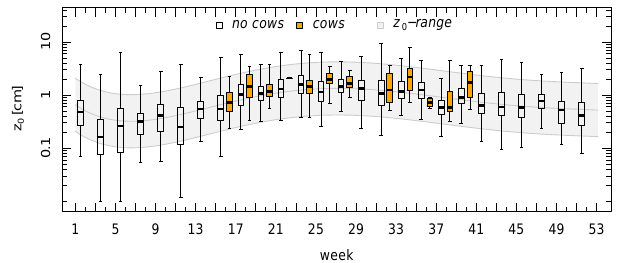
Figure 8. Effect of cows on roughness length ( z 0 ). Box plots of 30min z 0 values determined by Eq. (2) for u> 1.5ms − 1 as a func- tion of average footprint weight of the cow herd ( ϕ herd ) based on GPS data. Whiskers cover the full data range. Orange for cases with cows, green for cases with no cows in the footprint.